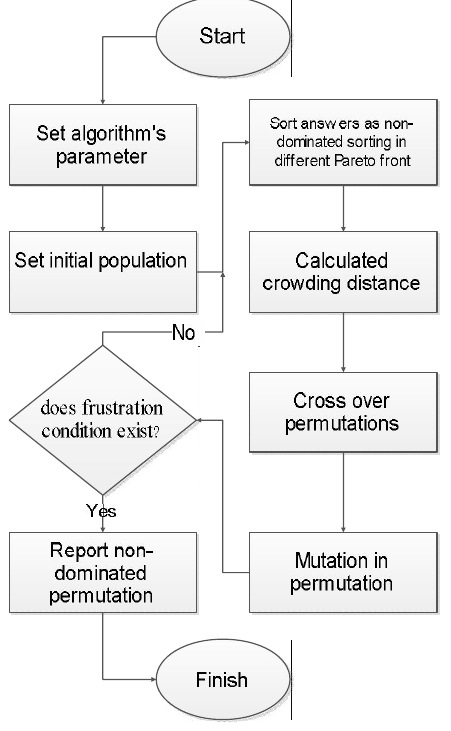
Fig. 2. NSGA-II algorithm for solving permutation problems with multiple weighted